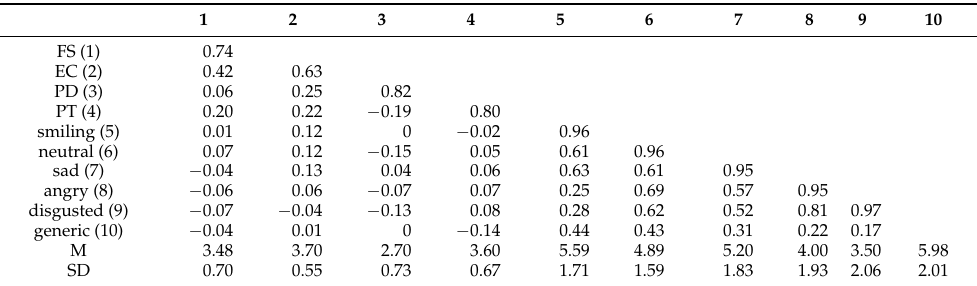
Table 1. Correlations and descriptive statistics (M and SD) for the subscales of trait empathy and the dictator offers for the different recipients and the generic dictator game. Reliabilities ( ω ) are displayed on the diagonal, except for the one-shot generic dictator